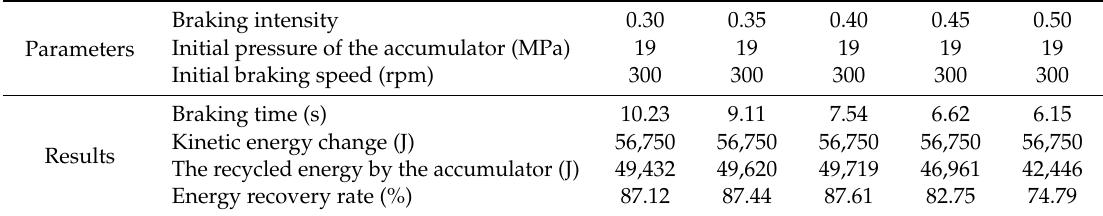
Table 3. The simulation results in the operating mode with di ff erent braking intensity.